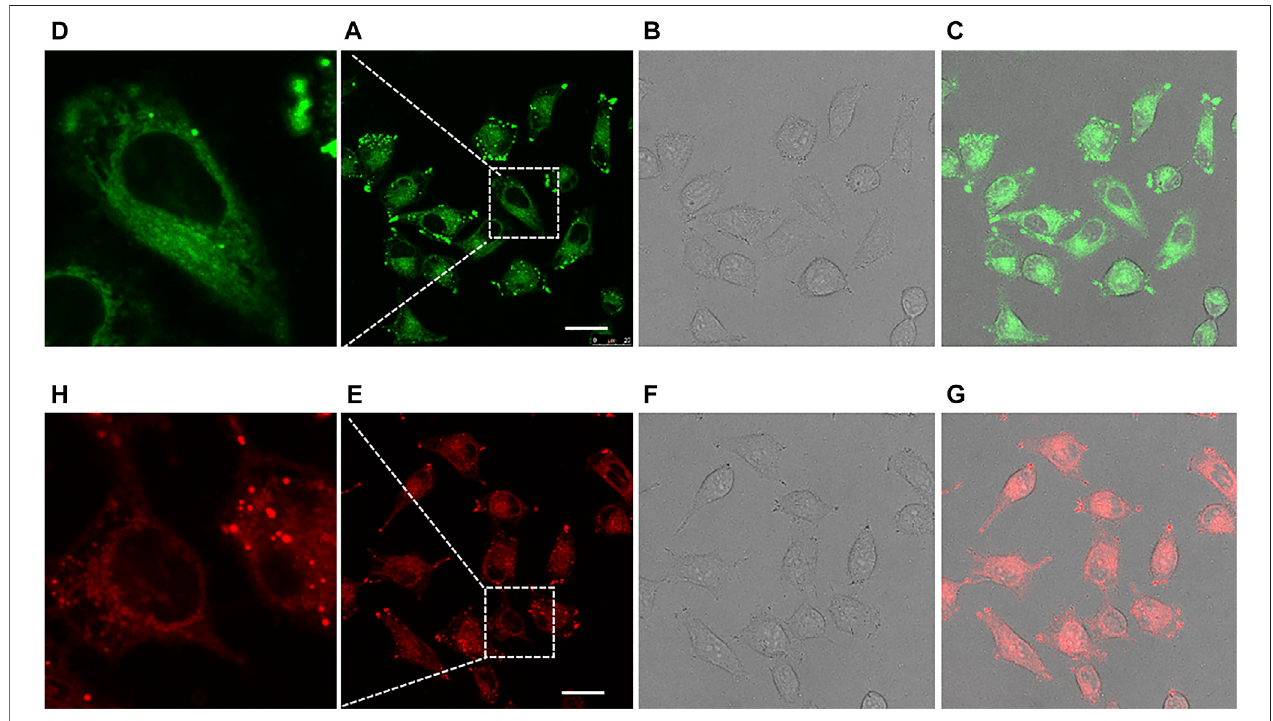
FIGURE5| Confocal fl uorescenceimagingofHeLacellsculturedwith 13 [Ex:405nm;Em:480 – 600nm; (A – D) ]and 13B [Ex:405nm;Em:550 – 700nm; (E – H) ]for 30 min. Each compound was administrated at 20 μ M. The 2nd row of pictures represented the images taken under fl uorescence fi eld, with partially expanded view shown in the 1st row. The 3rd row of pictures represented the images taken under bright fi eld. The 4th row of pictures were merged ones. Scale bar: 25 μ M.